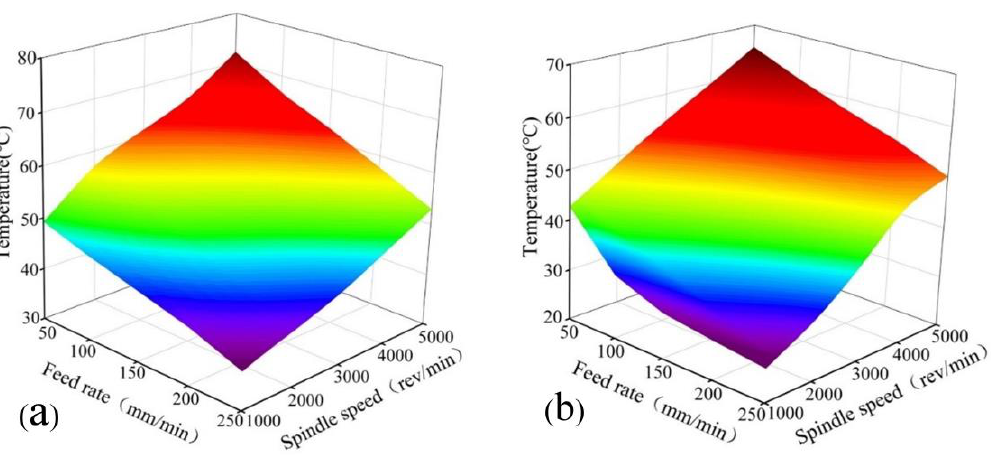
Figure 7. Three-dimensional graph of drilling temperature under different drilling parameters. ( a ) h1; ( b ) at at h1; ( b ) at h2.